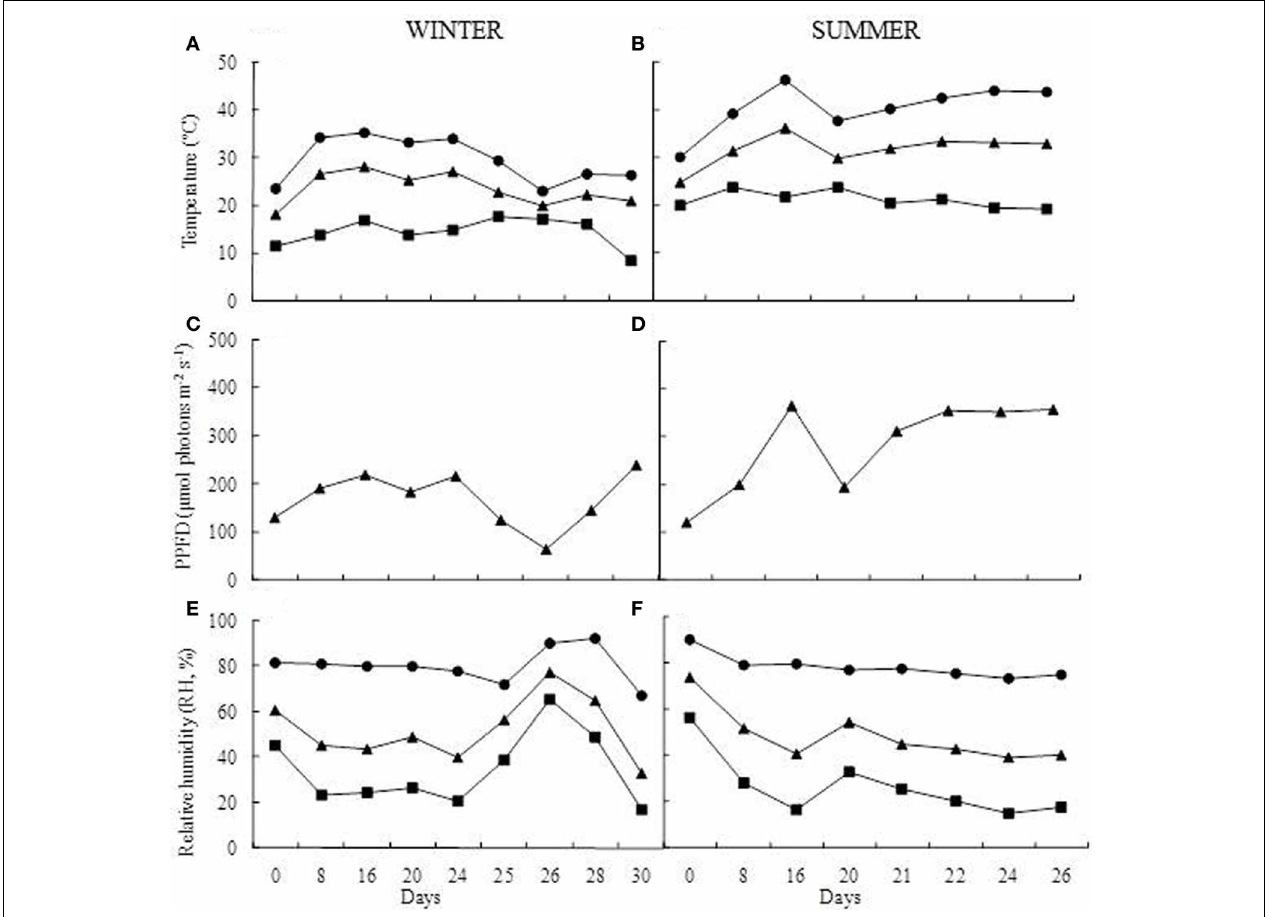
FIGURE 2 | Greenhouse growth conditions. Temperature ( ◦ C) (A,B) , photosynthetic photon flux density (PPFD, μ mol photons m − 2 s − 1 ) (C,D) , and relative humidity (RH, %) (E,F) . Maximum ( • ), mean ( (cid:2) ), and minimum values ( (cid:3) ) during of winter and summer seasons.